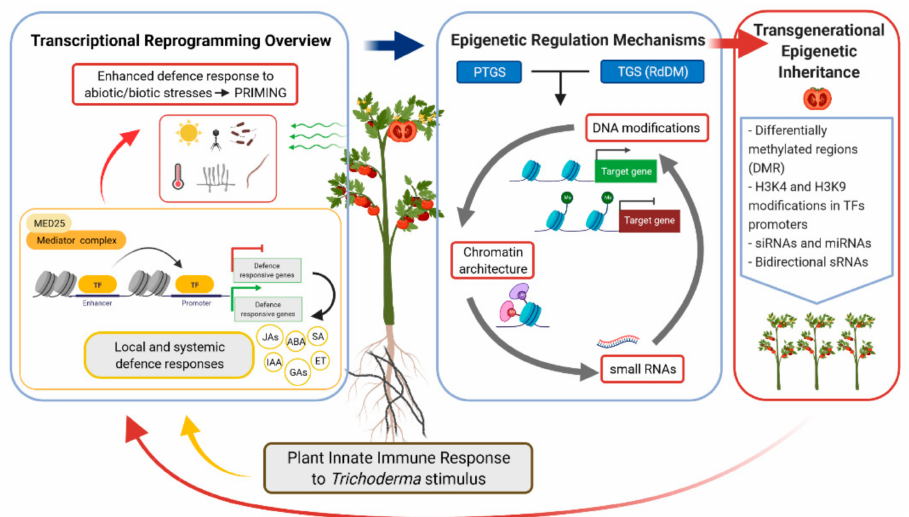
Figure 2. Schematic outline of plant immune local and systemic responses to Trichoderma priming stimulus. These responses involve a transcriptional reprogramming process where the action of enhancers (Mediator complex-subunit MED25) and transcription factors (TF) have a key role in the regulation of phytohormone synthesis pathways. Regulation of these processes is mediated by small RNAs (sRNA) through a transcriptional gene silencing (TGS) mechanism—mainly through the RNA-directed DNA methylation (RdDM) pathway—or through post-transcriptional gene silencing (PTGS), which has been proven to impact whole-genome DNA methylation patterns. The inheritance of these epigenetic marks on the offspring leads to the plant immune response against abiotic or biotic stresses without the need for an external stimulus triggered by Trichoderma . Abbreviations: SA, salicylic acid; JAs, jasmonates; ET, ethylene; ABA, abscisic acid; IAA, indole-3-acetic acid; GAs, gibberellins. Created in